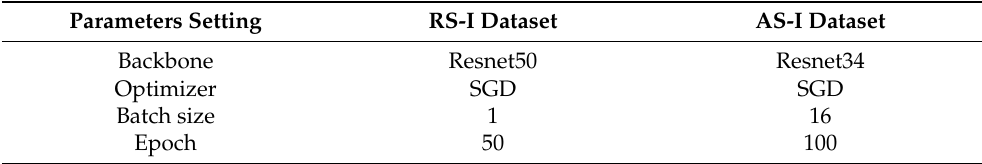
Table 1. Experimental basic parameters setting. Parameters Setting RS-I Dataset AS-I Dataset Backbone Resnet50 Resnet34 Optimizer SGD SGD Batch size Epoch 50